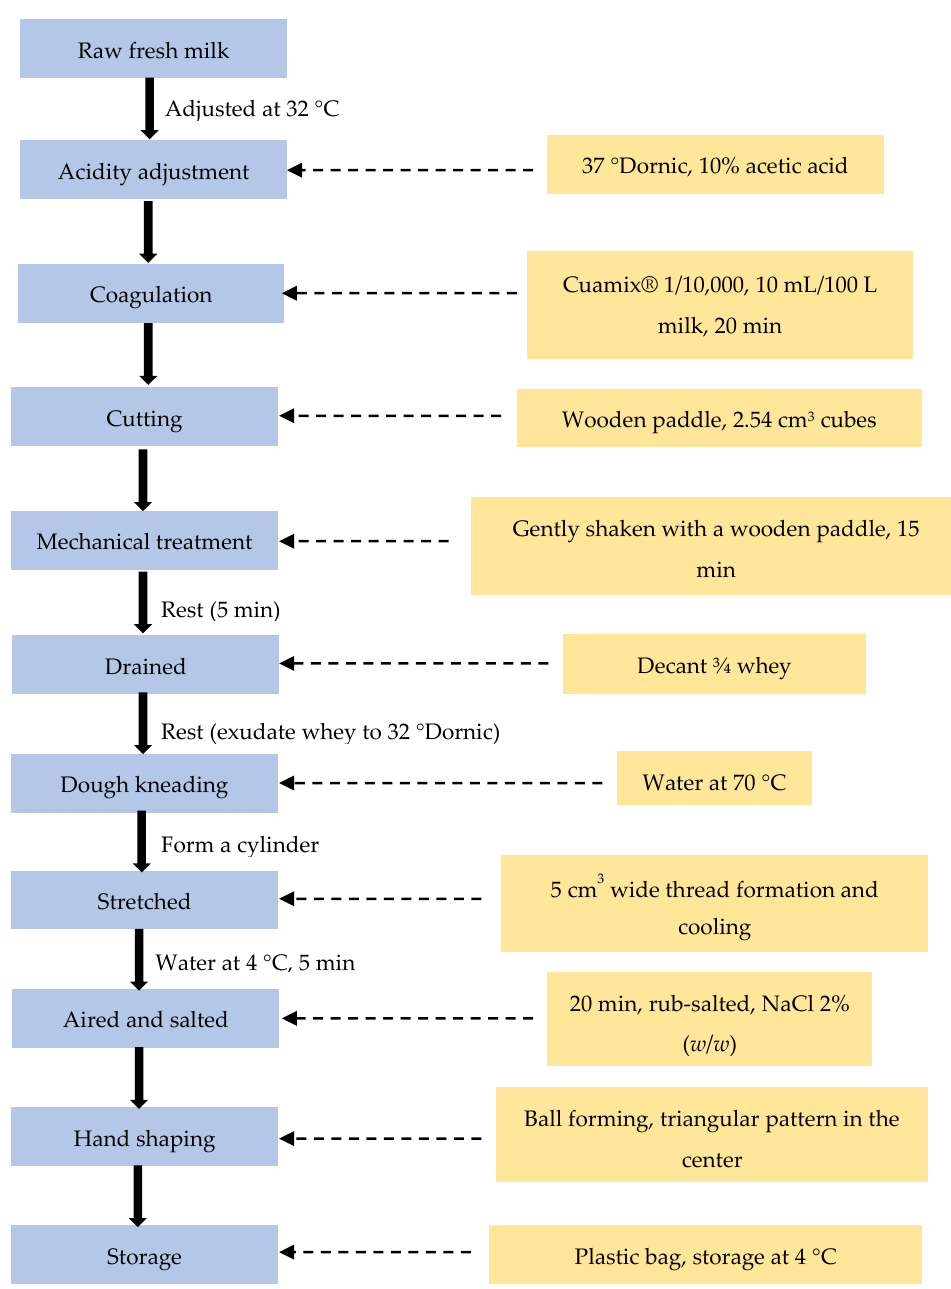
Figure 1. Flow chart representing the production of Oaxaca cheese [13].